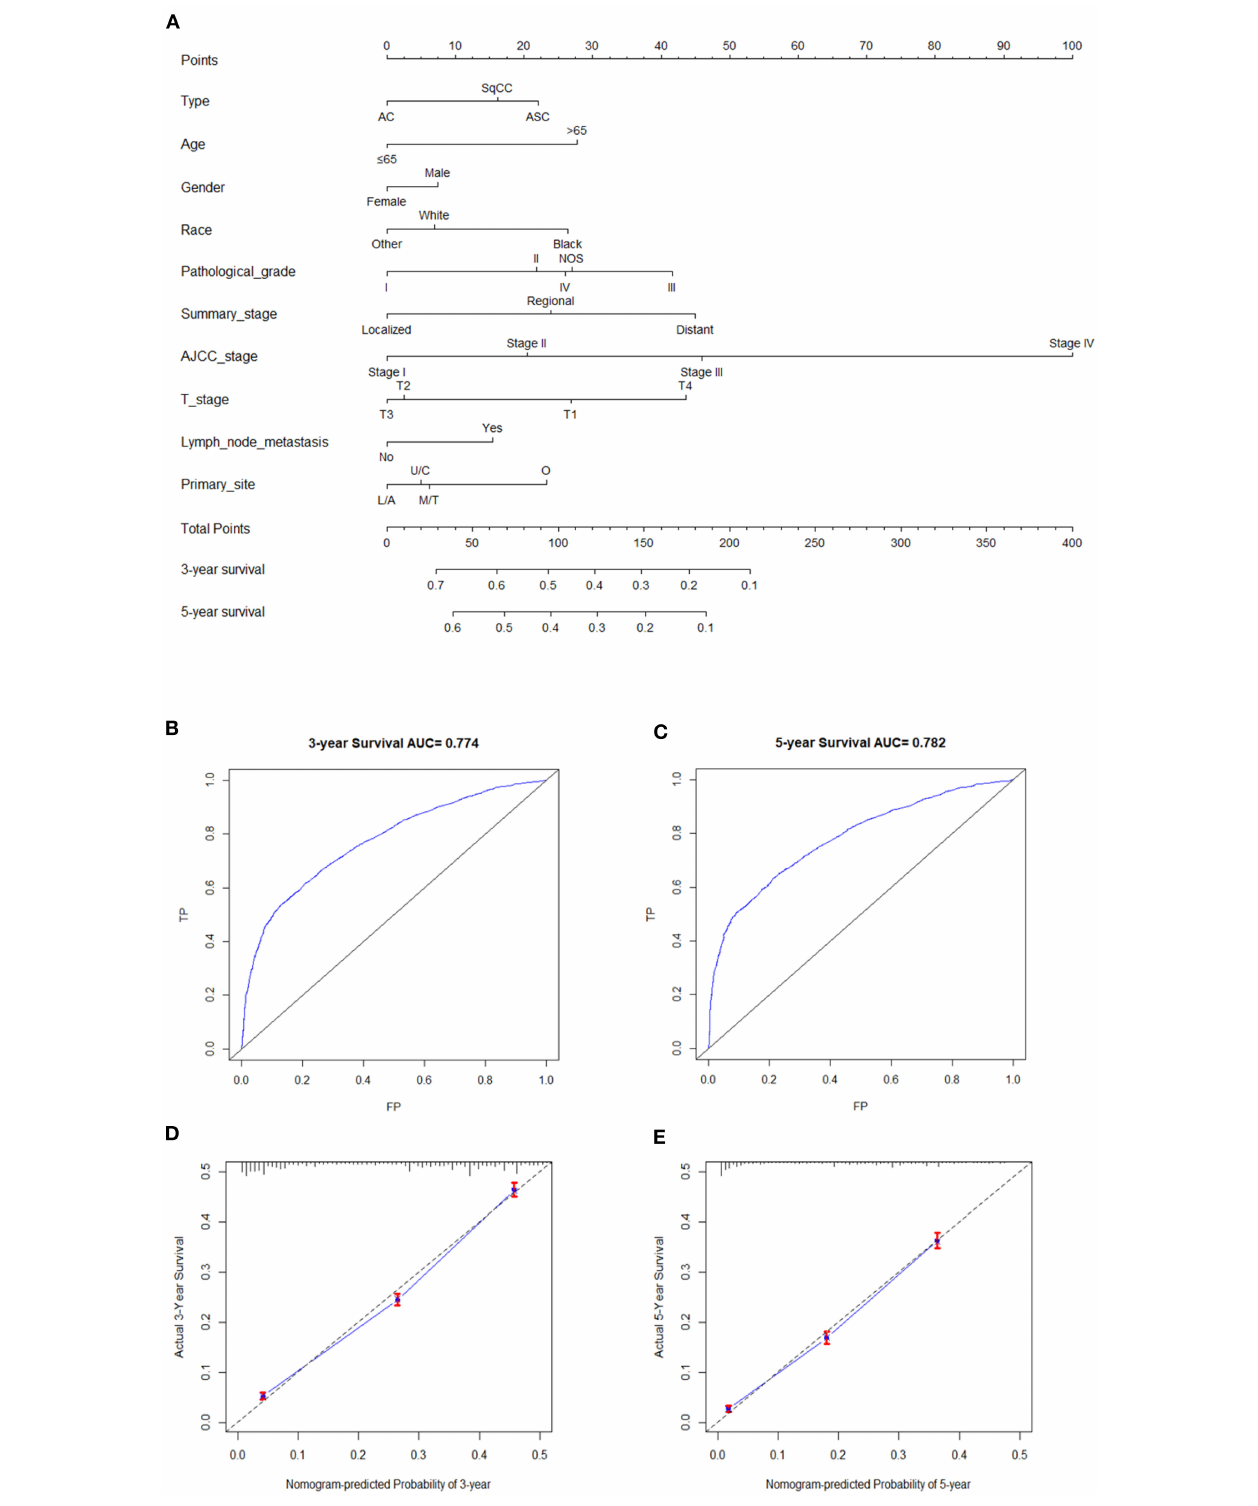
FIGURE 4 | (A) Nomogram for all three cancer types patients. C/U, Cervical/Upper; T/M, Thoracic/Middle; A/L, Abdominal/Lower; O, Overlapping. (B,C) are ROC curves and AUC of nomogram model for 3- and 5-year OS. (D,E) are calibration curves of 3- and 5-year OS rates.